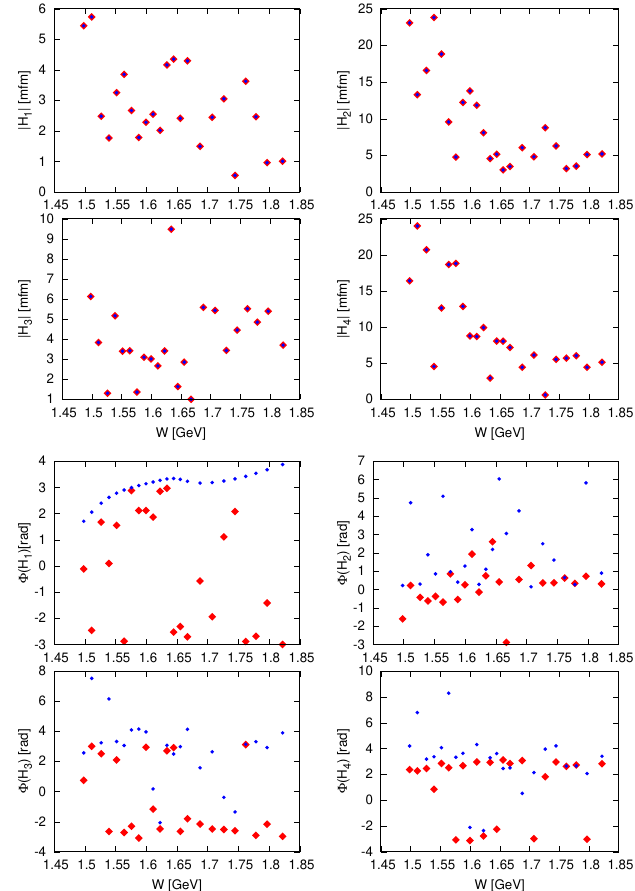
Figure 2: (Color online) Helicity amplitudes at fixed an- gle for the real data of ref.[2] unconstrained, before the rotation (red symbols) and after the phase rotation with H 1 defined by Eq. (1) (blue